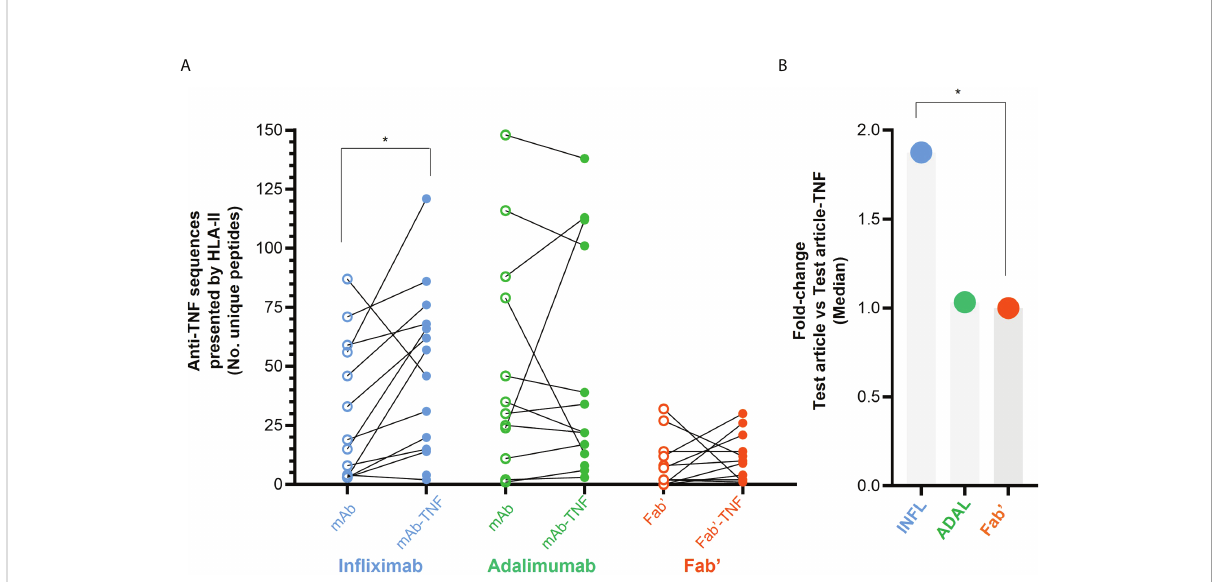
FIGURE 7 HLAII-presented sequences derived from anti-TNF biotherapeutics. (A) Number of unique anti-TNF peptides derived from DCs loaded with test article alone (empty circles) or in complex with TNF (full circles) per donor, corresponding to INFL (blue), ADAL (green) and Fab ’ (orange); (*p < 0.013 by Wilcoxon marched-pairs signed rank test) (B) Median fold-change anti-TNF vs. anti-TNF complexed with TNF based on the number of unique anti-TNF peptides detected per sample. ns, non-signi fi cant; *p > 0.036 by Mann-Whitney